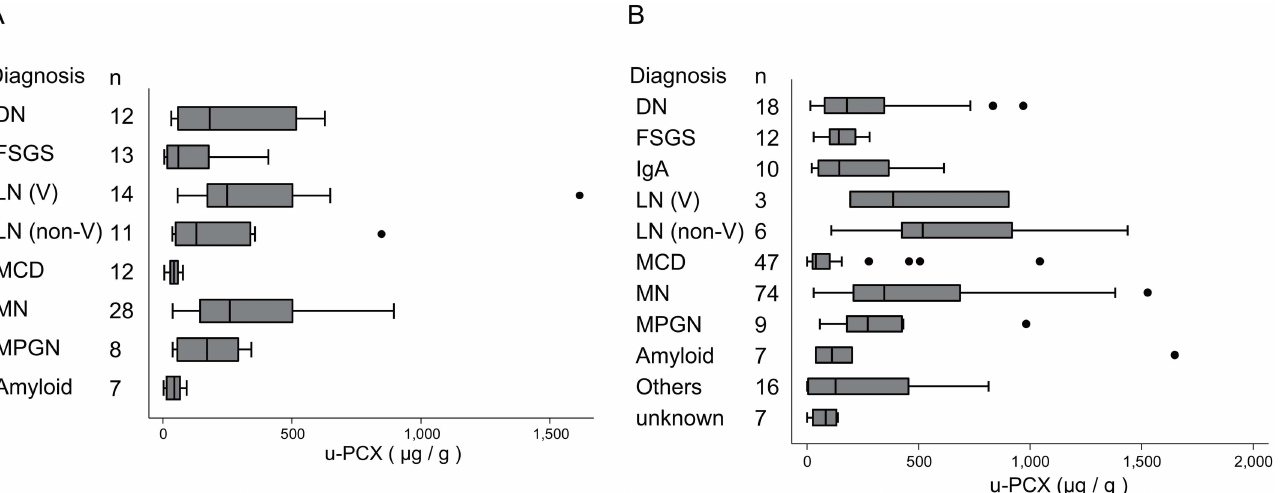
PLOS ONE | DOI:10.1371/journal.pone.0163507 September 26,